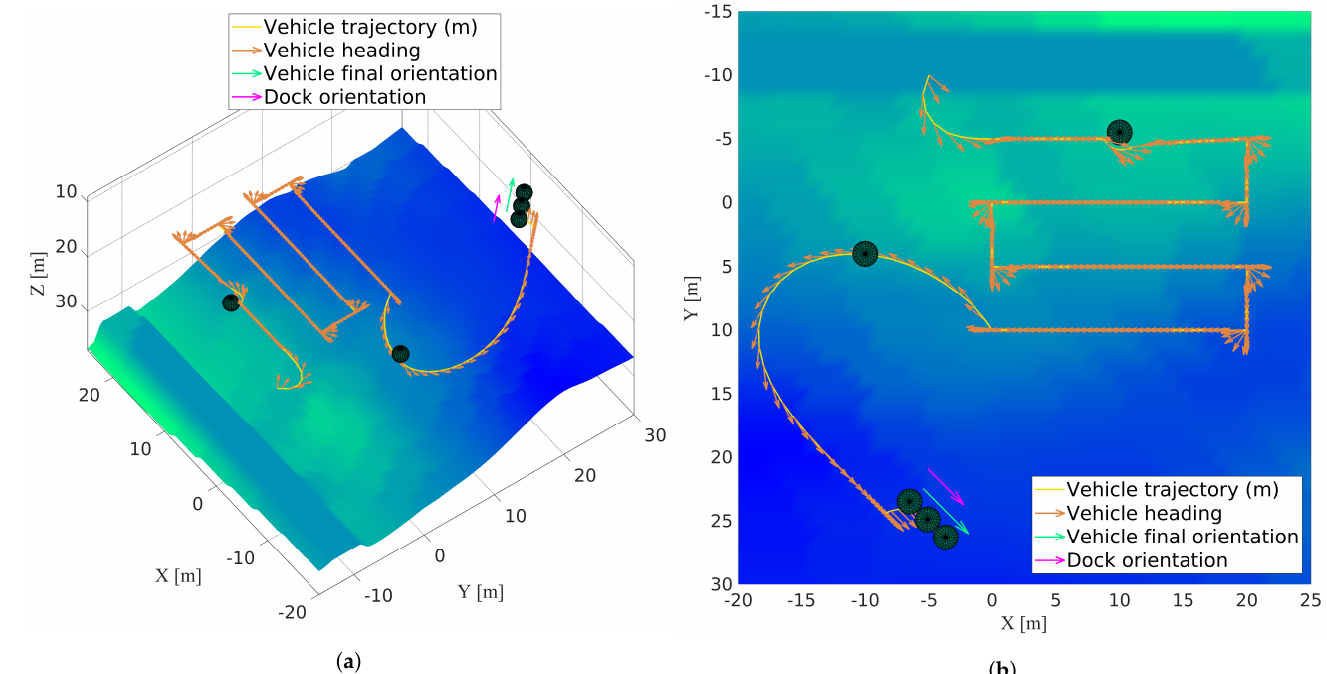
Figure 12. Constant depth mission: Plot showing the mission and docking to a moving docking station situated close to the sea-level ( a ) in the 3D space ( b ) from top view.